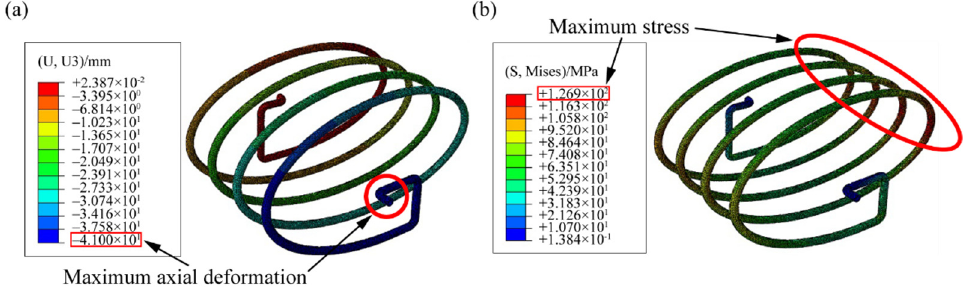
Figure 17. The converged results of simulation: ( a ) axial deformation and ( b ) maximum stress.